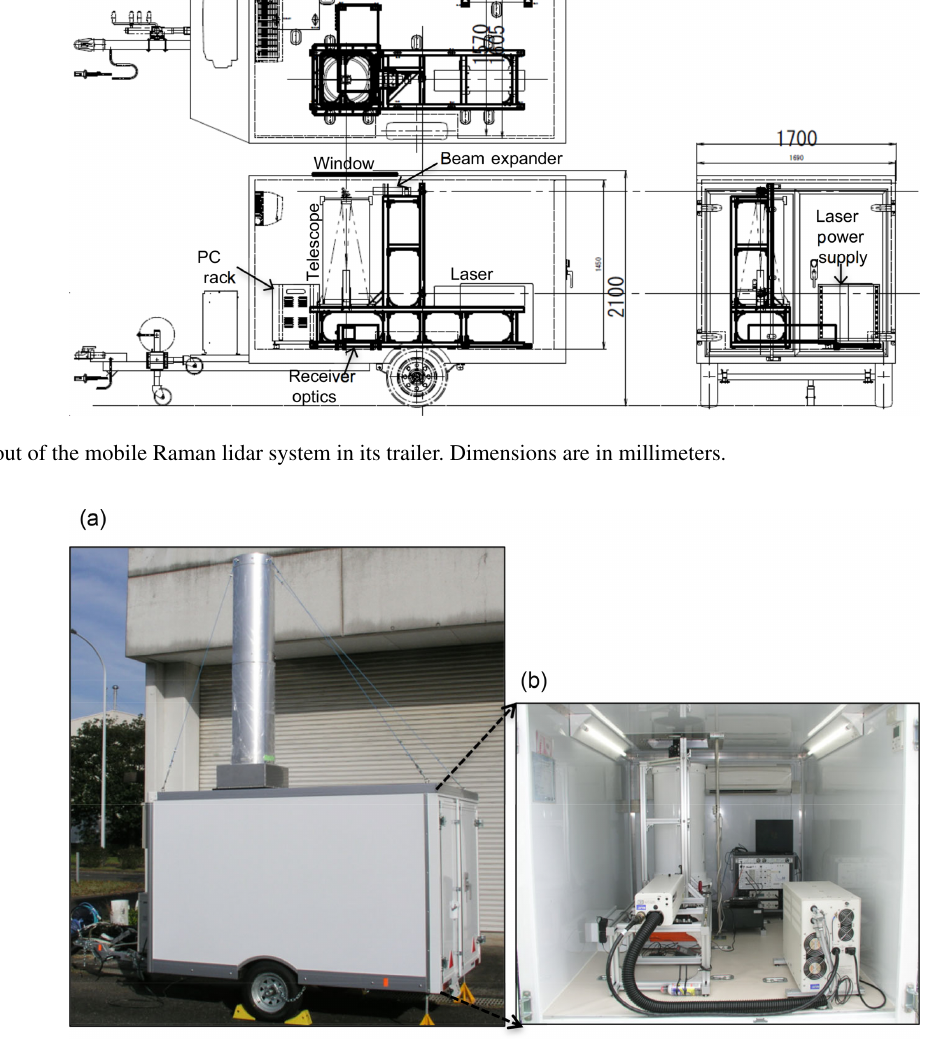
Figure 3. Photographs of the MRL trailer (a) and its interior (b)